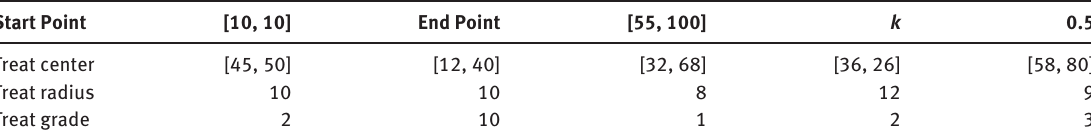
Table 3. Information about